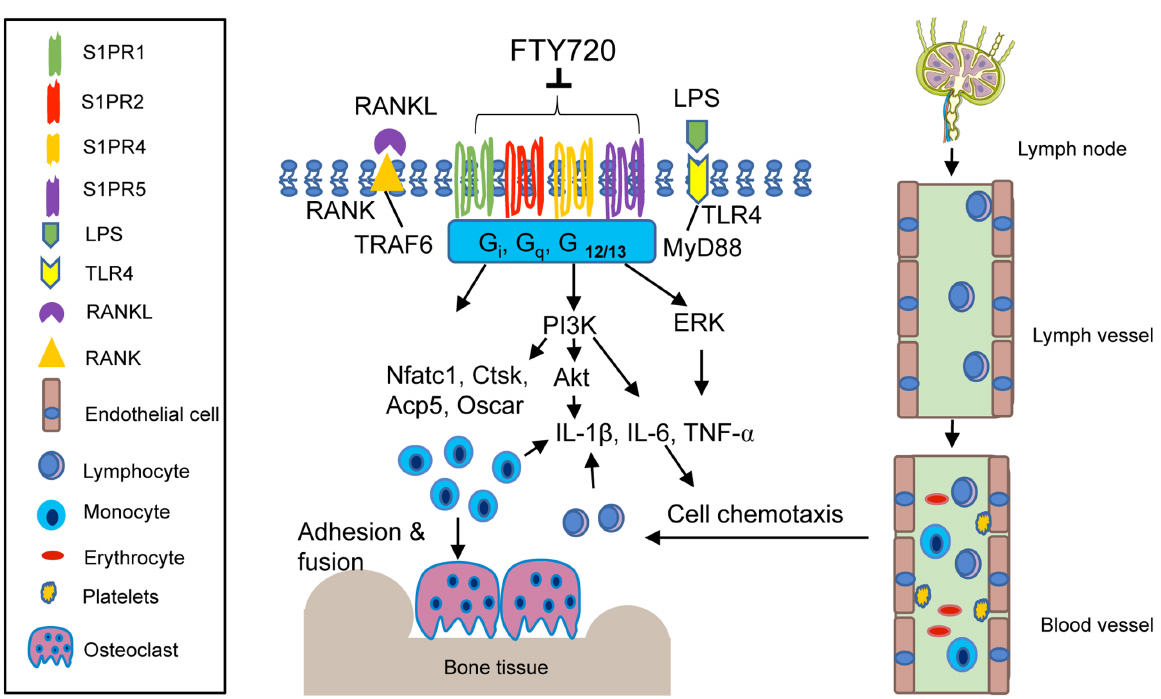
Figure 3. Simplified illustration of biological effect of FTY720 in inflammatory bone loss diseases. FTY720 can internalize and partially degrade multiple S1PRs, including S1PR1, S1PR2, S1PR4, and S1PR5. FTY720 inhibits IL-1 β , IL-6, and TNF- α inflammatory cytokine release by blocking PI3K, Akt, and ERK signaling pathways. FTY720 suppresses T lymphocyte egress from draining lymph nodes to the lymph and peripheral blood. Reduction of inflammatory cytokines and the number of T lymphocytes in the blood subsequently decreases monocytes and T lymphocytes in the bone and soft tissues. Additionally, FTY720 inhibits Nfact1, Ctsk, Acp5, and Oscar genes, suppressing RANKL-induced